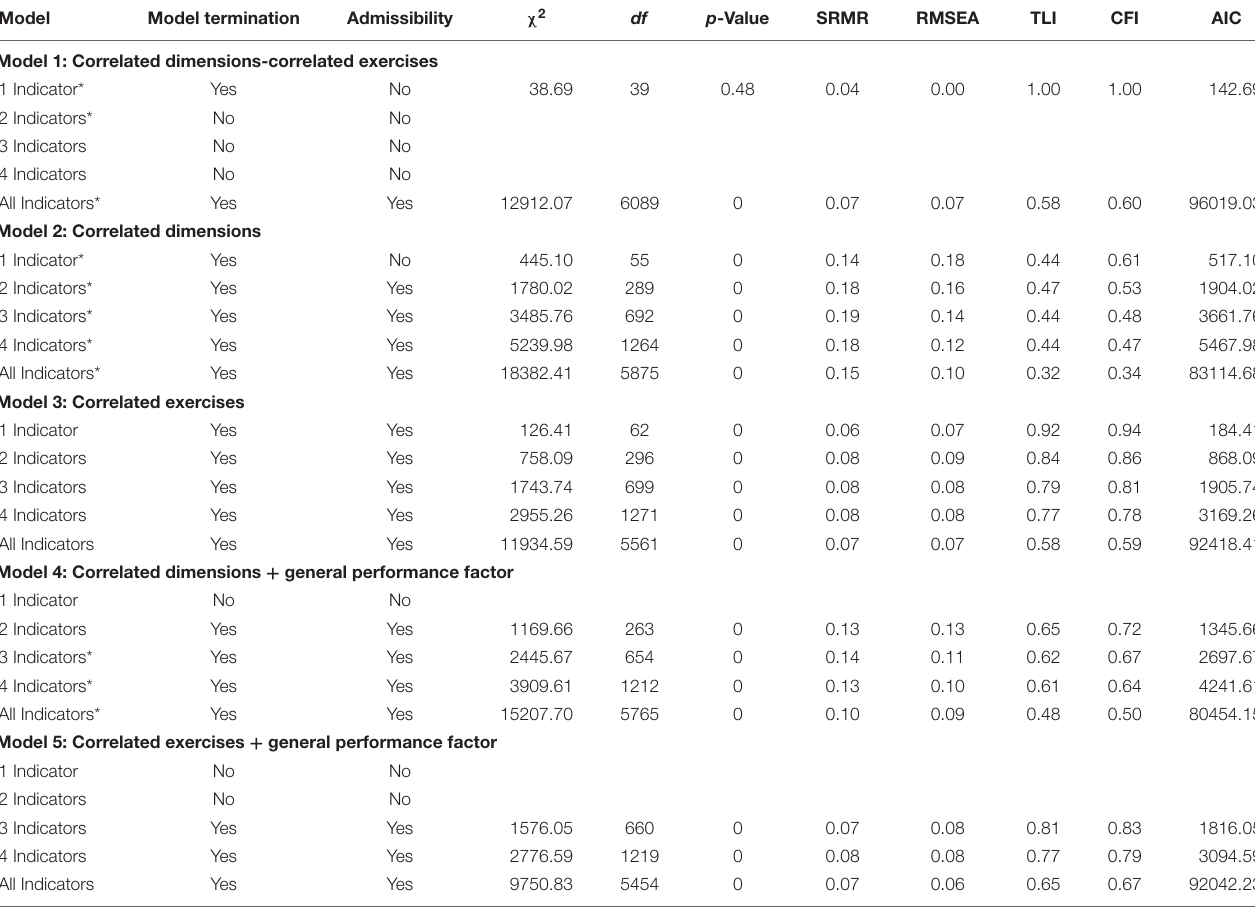
TABLE 1 | Model-data fit indices for confirmatory factor analysis models for combinations of single indicators.